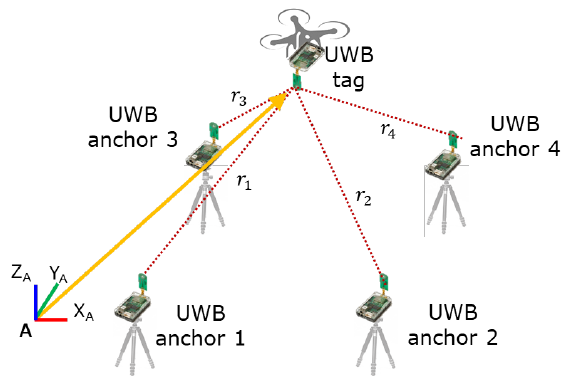
Figure 1. Description of UWB tag, UWB anchors and anchor frame